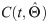
Model 1 output: (a) the best-fit solution obtained by fitting C(t,Θ^) (dashed curve) in system (1) to the cumulative number of H1N1 cases is displayed. (b) Dynamics of the media effect term M(t)=max{0,aI(t)+bdIdt(t)}.